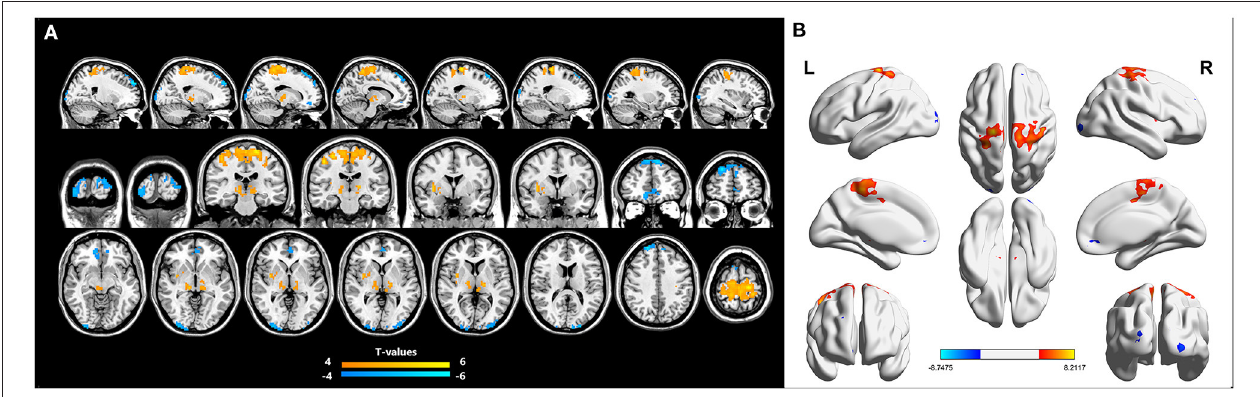
FIGURE 1 | Significantly different ReHo brain areas in patients with congenital blindness. Blue regions (RMFGorb, bilateral MOG, RSFGdl) indicate lower ReHo values, while red regions (the bilateral thalamus, the right insula, and the LPCL) represent higher ReHo values (single voxel P < 0.05, AlphaSim corrected; cluster size > 50). The map of the brain regions with statistical differences between two groups (A) and three-dimensional distributions (B) . ReHo, regional homogeneity; RMFGorb, the right orbital part of middle frontal gyrus; MOG, the middle occipital gyrus; RSFGdl, the right dorsolateral superior frontal gyrus; LPCL, the left paracentral lobule.